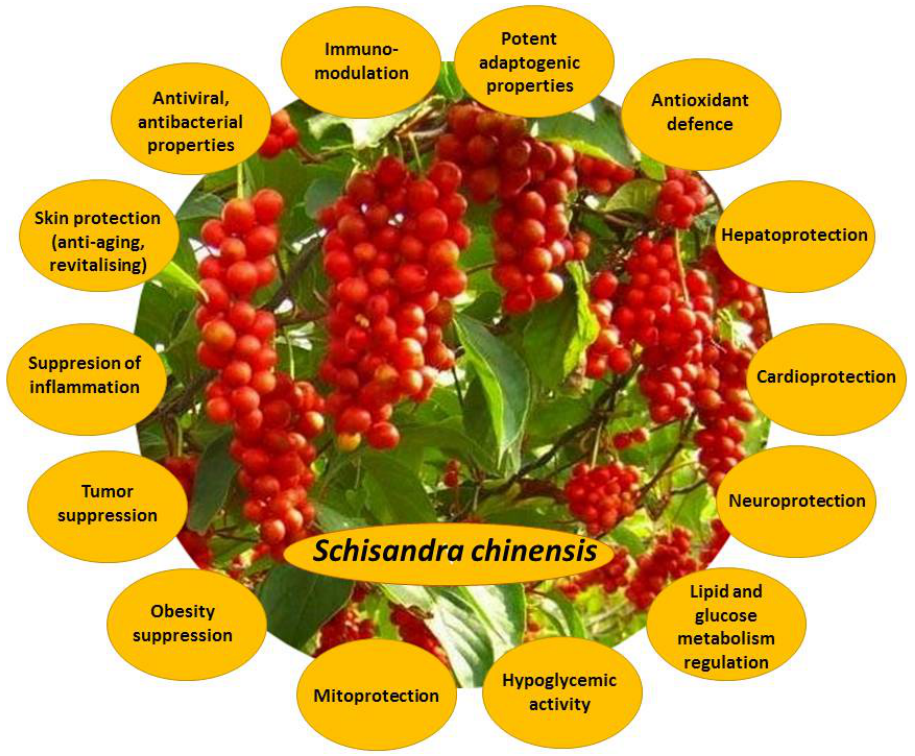
Figure 2. Main biological effects of Schisandra chinensis fruit extracts and their bioactive com- pounds.